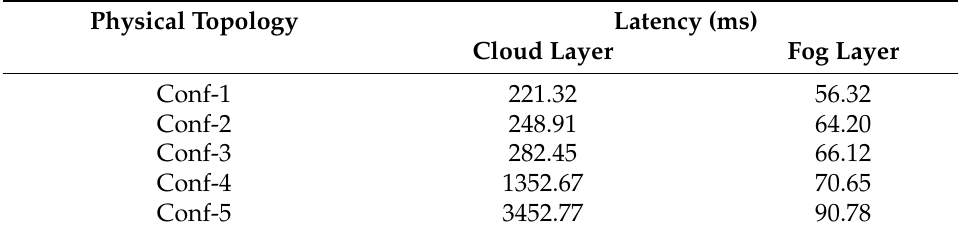
Table 6. Comparison of latency.